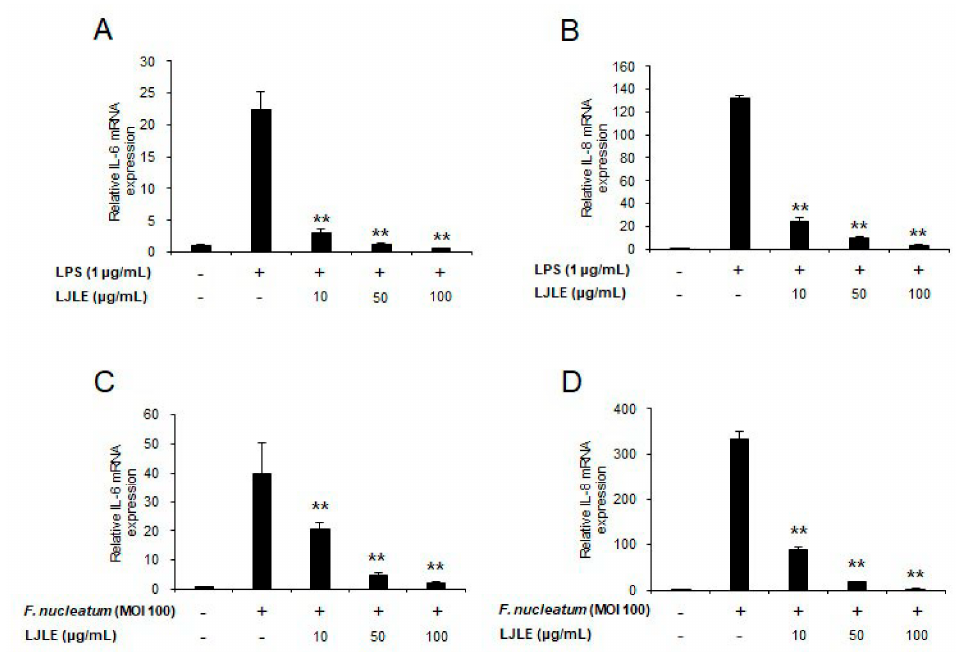
Figure 5. Pretreatment with LJLE inhibits pro-inflammatory cytokine expression in LPS or F.